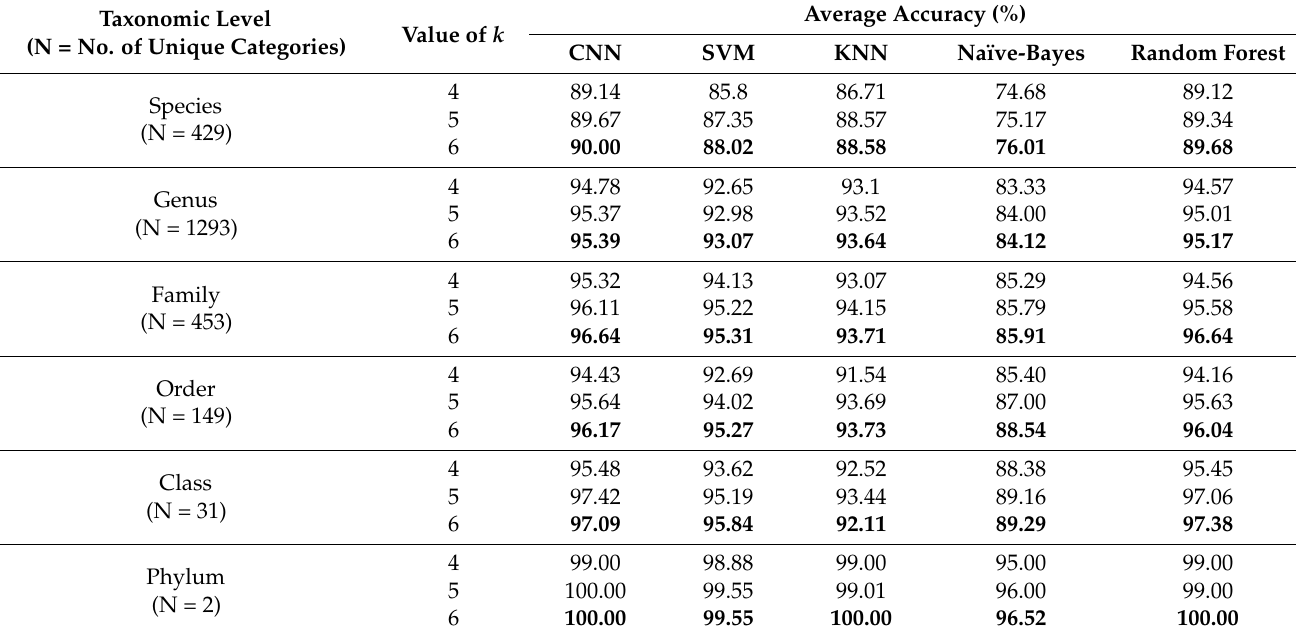
Table 7. Average accuracies (%) obtained by CNN, SVM, KNN, Naïve-Bayes and Random Forest classifiers with different k -mer sizes. For each taxonomic level (from Class to Species), the training dataset consists of 100 sequences per category. Phylum level dataset consists of 500 sequences per category. Highest values are highlighted in bold.